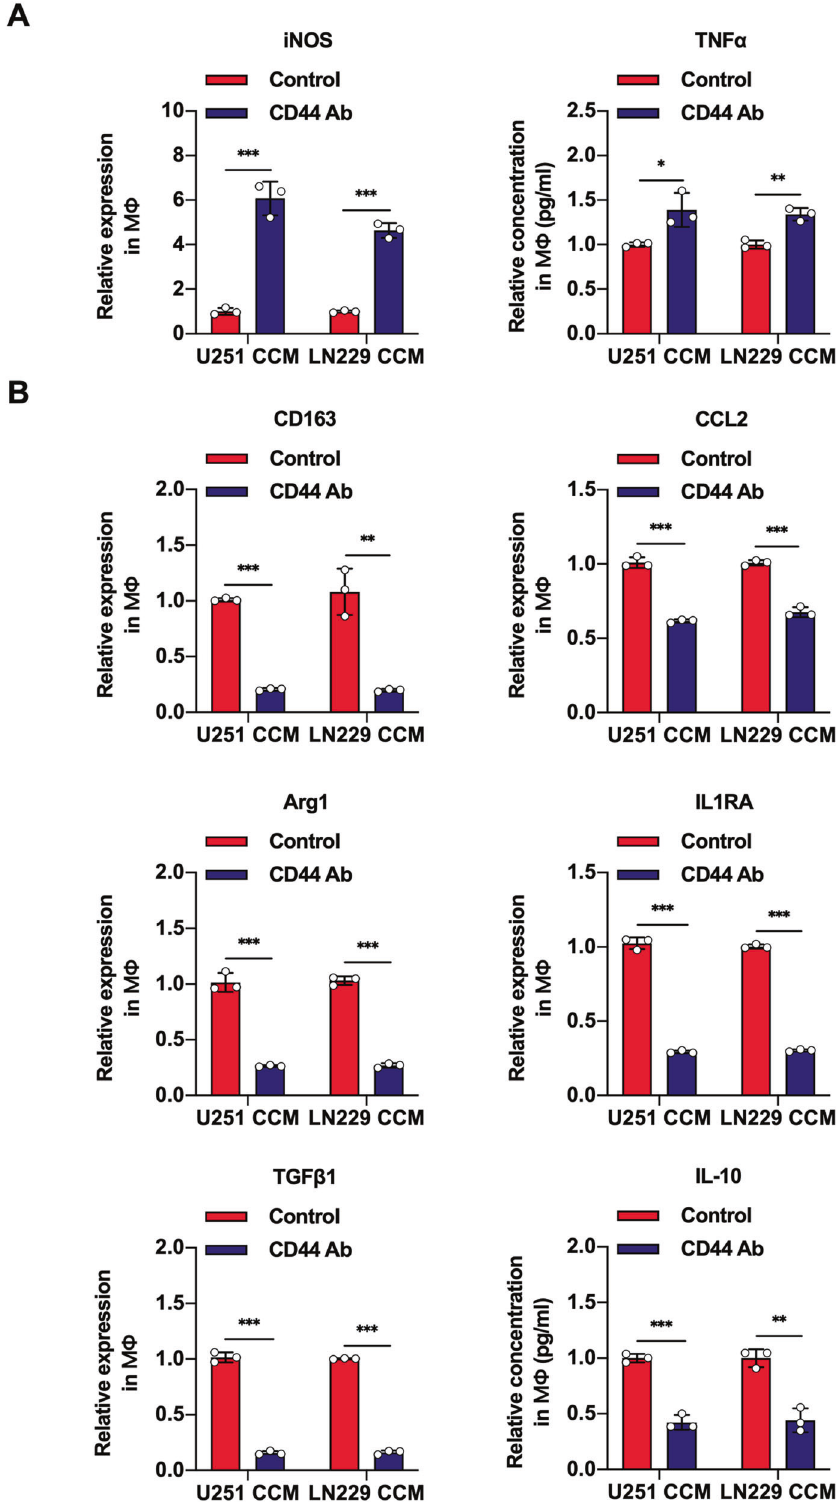
Fig. 2 Blocking the binding of HA to CD44 on macrophages modulates M1 macrophages polarization in glioblastoma. A , B Macrophages pretreated with the anti-CD44 antibody (6 μ g/ml) were cultured with CCM for 48 h. The relative mRNA expression levels of iNOS, CD163, CCL2, Arg1, IL1RA, and TGF β 1 in macrophages were detected by qRT-PCR. Induced macrophages were cultured alone in FBS-free medium for another 48 h, and the relative concentrations of TNF α and IL-10 secreted from the macrophages were detected by ELISA. Error bars show mean ± SD. * P < 0.05, ** P < 0.01, and *** P < 0.001.